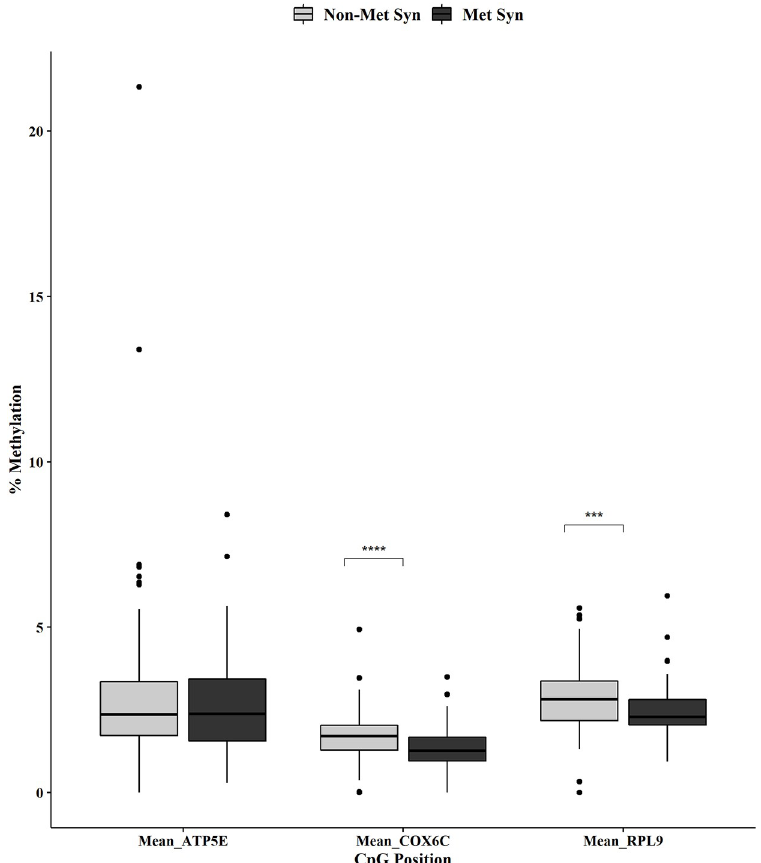
Fig 4. ATP5E , COX6C and RPL9 overall promoter DNA methylation by MetS status. Mean methylation within the promoters of ATP5E , COX6C and RPL9 in non-MetS (n = 110) and MetS (n = 74). Mann-Whitney U test was used for the statistical comparisons between the non-MetS versus MetS. ��� p < 0.001, ���� p < 0.0001.